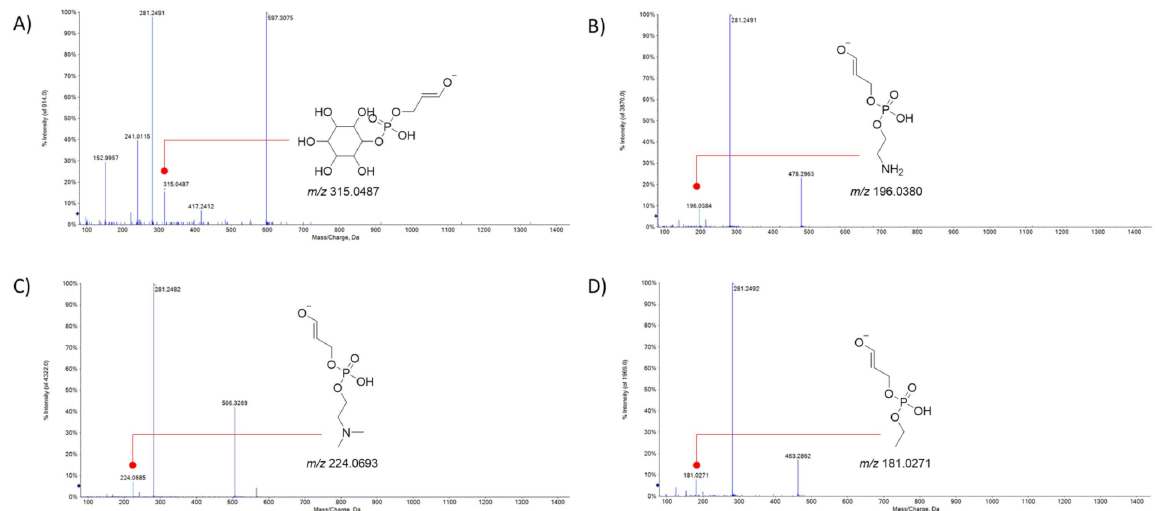
Figure 3. TOF-MS/MS spectra of compounds. TOF-MS/MS spectra of compounds 3 (cid:48) ( A ), 5 (cid:48) ( B ), 10 (cid:48) ( C ), and 11 (cid:48) ( D ). In the gray-colored boxes, diagnostic ions for the tentatively identified oleoyl-based lysophospholipids are reported. Theoretical m / z values are reported below each